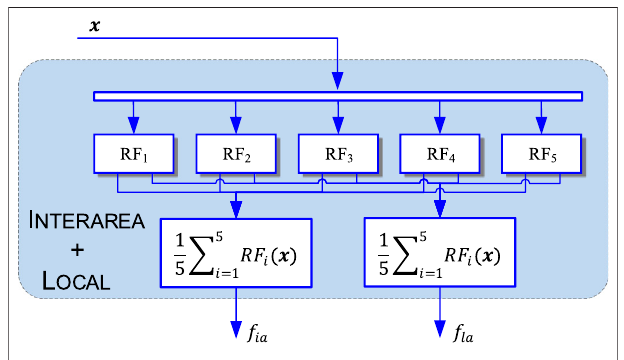
FIGURE 10 | Multivariate structure of 5-fold cross validated Inter-area and Local mode frequency prediction.